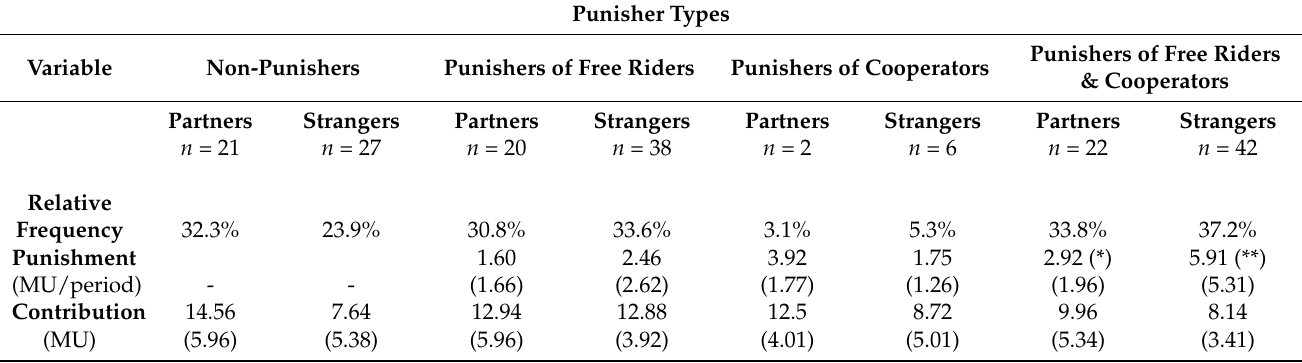
Table 2. Relative frequencies, punishment investments, and contributions by punisher’s